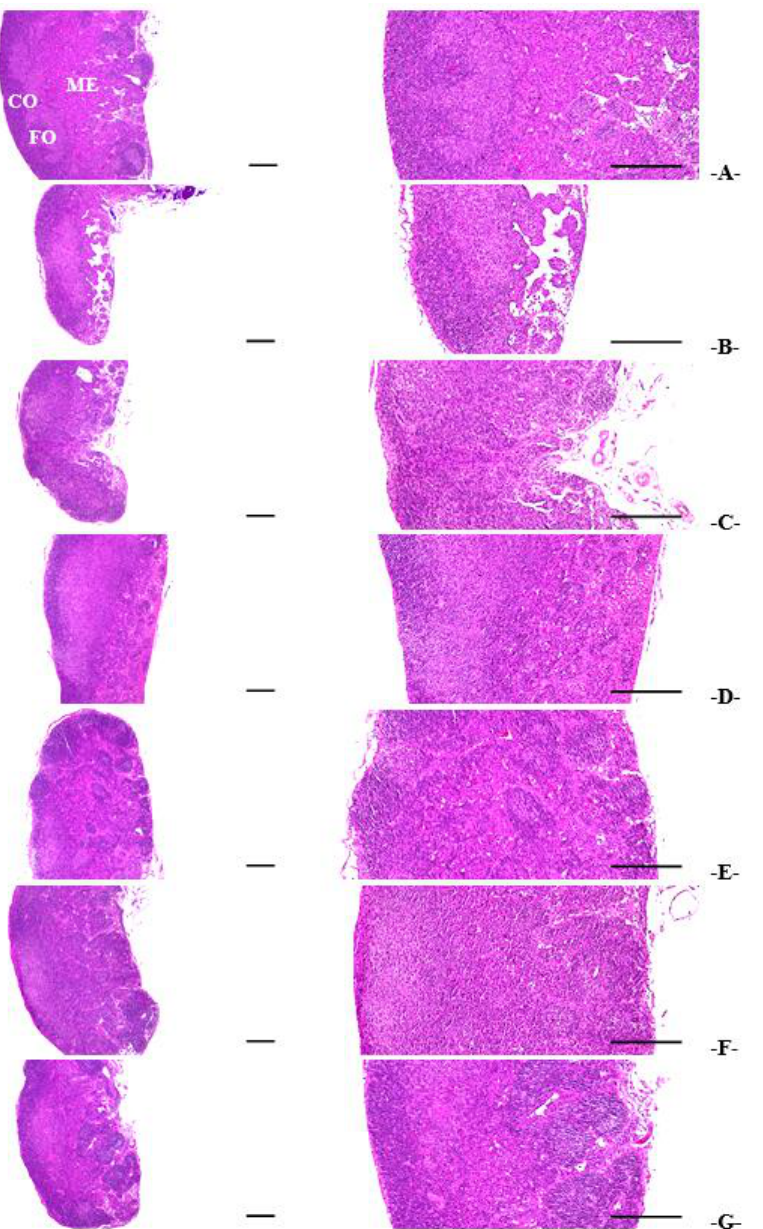
Figure 14. Representative histological profiles of the submandibular lymph nodes taken from intact or NCI-H520 tumor cell xenograft rodents. ( A ) = Intact control; ( B ) = tumor-bearing control; ( C ) = gefitinib 120 mg/kg; ( D ) = SKOG 400 mg/kg; ( E ) = gefitinib 120 mg/kg and SKOG 400 mg/kg; ( F ) = gefitinib 120 mg/kg and SKOG 200 mg/kg; ( G ) = gefitinib 120 mg/kg and SKOG 100 mg/kg. AR = Adenophorae Radix; KOG = Kyeongokgo ; SKOG = sasam-Kyeongokgo . CO = cortex; ME = medullar; FO = follicle. All Hematoxylin-Eosin-stained . Scale bars = 400 μm. Table 9. Changes in the periovarian fat pad histomorphometry of NCI-H520 tumor cell xenograft mice.